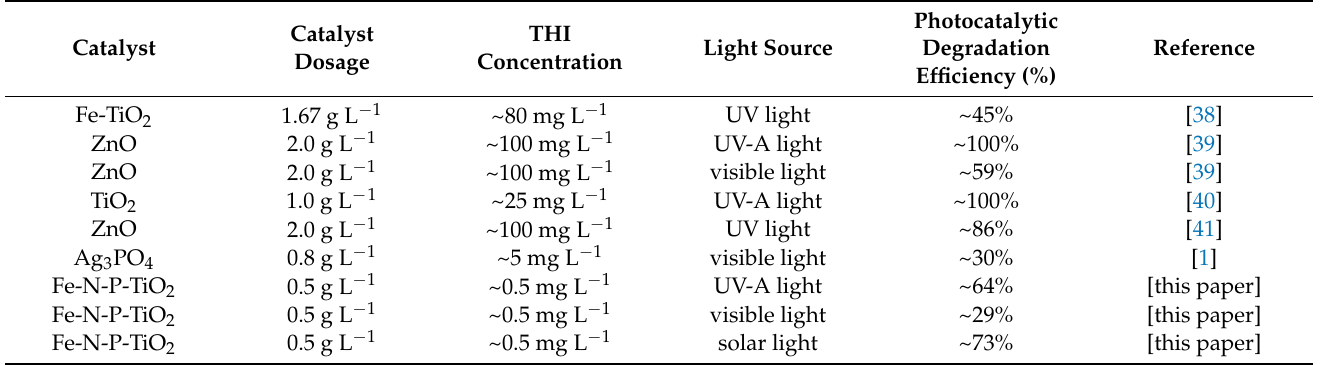
Photocatalytic Light Source